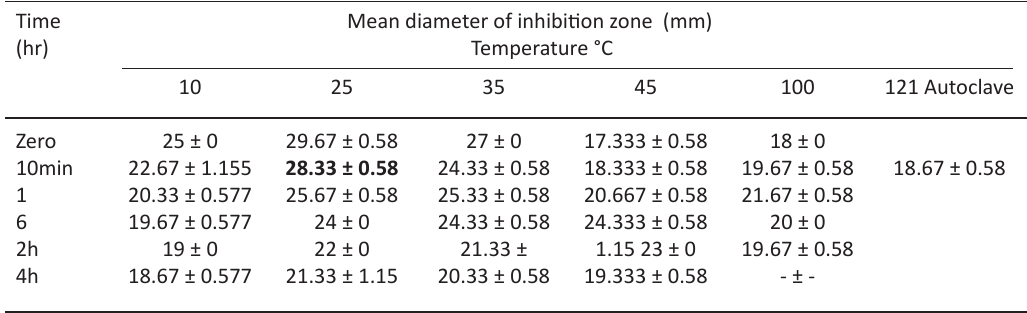
Table 5. Antimicrobial activity of the mixture of ethyl acetate extract of P.plebeium, PP and E hirta, EH against MRSA, B39 in relation to different incubation temperatures Time